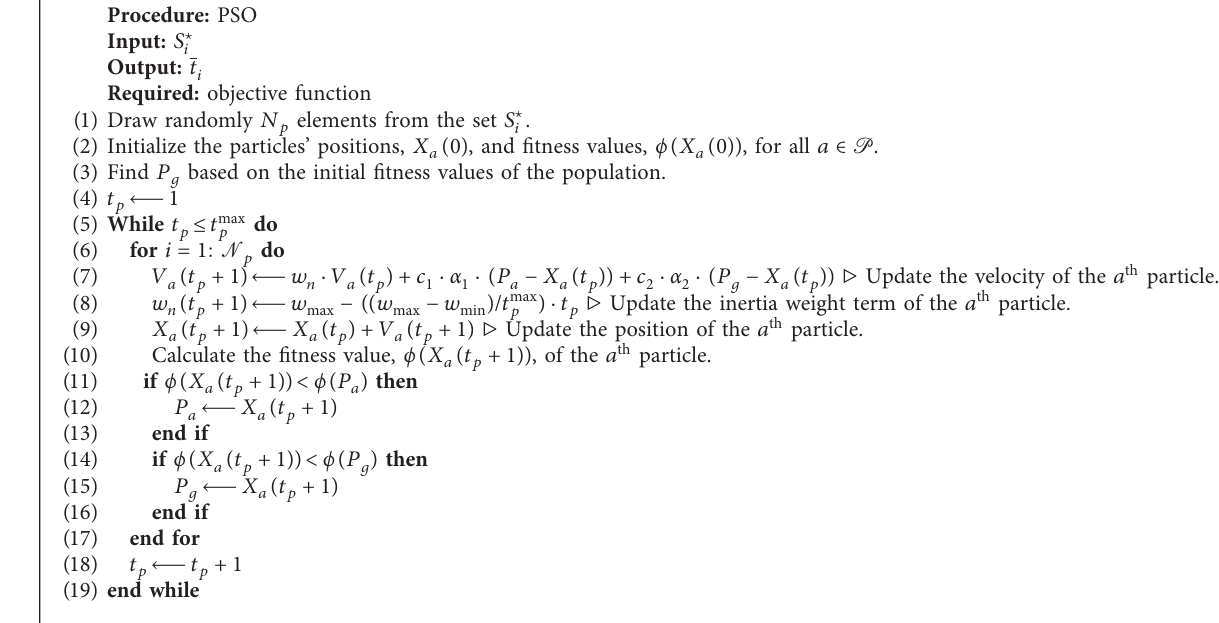
A LGORITHM 1: Pseudocode of the